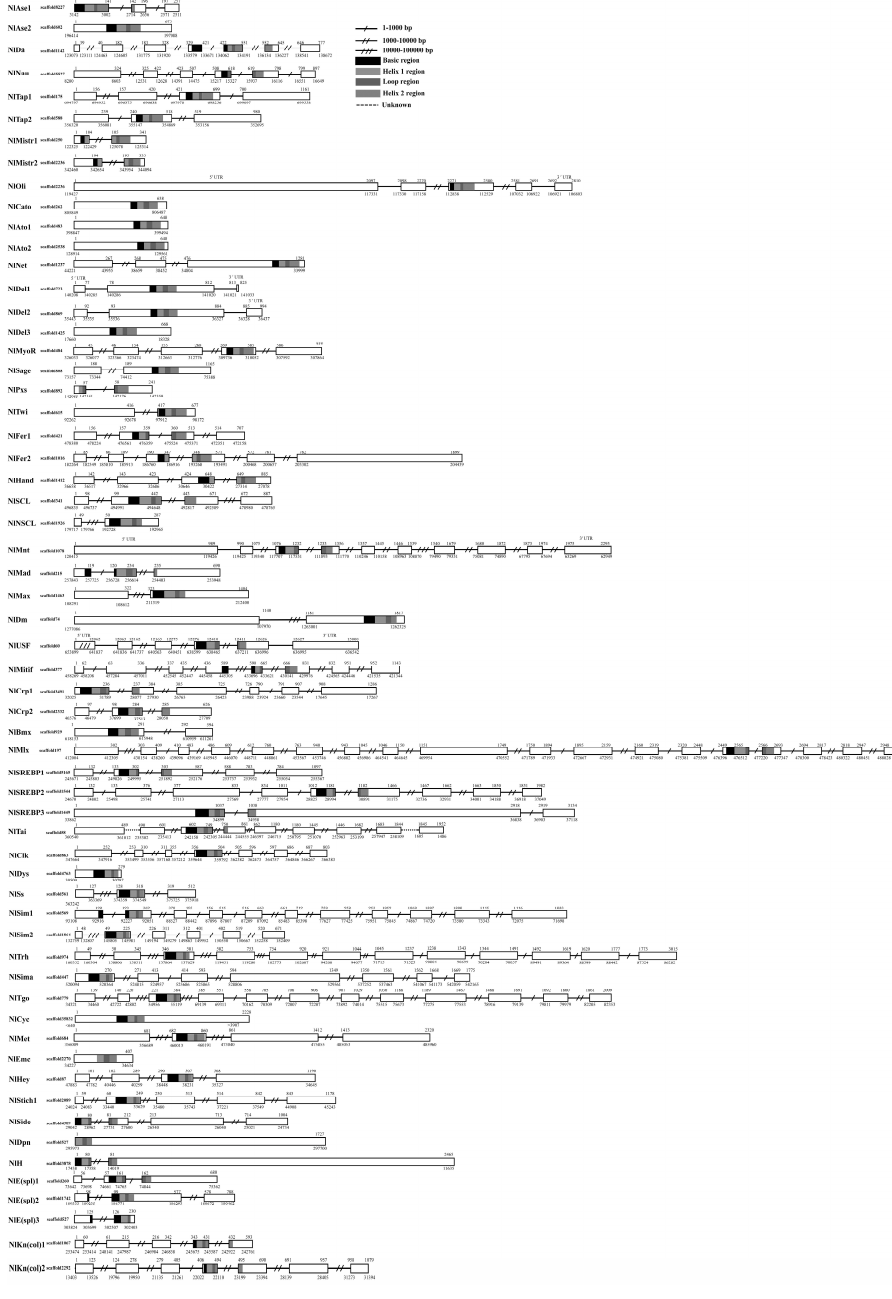
Figure 4. The exon–intron structure of each NlbHLH genes in the N. lugens genome. Black and white boxes represent exons and introns, respectively. The basic, helix 1, loop and helix 2 regions are shaded in black, respectively. The sites of cDNA and scaffolds are indicated above and below, respectively.